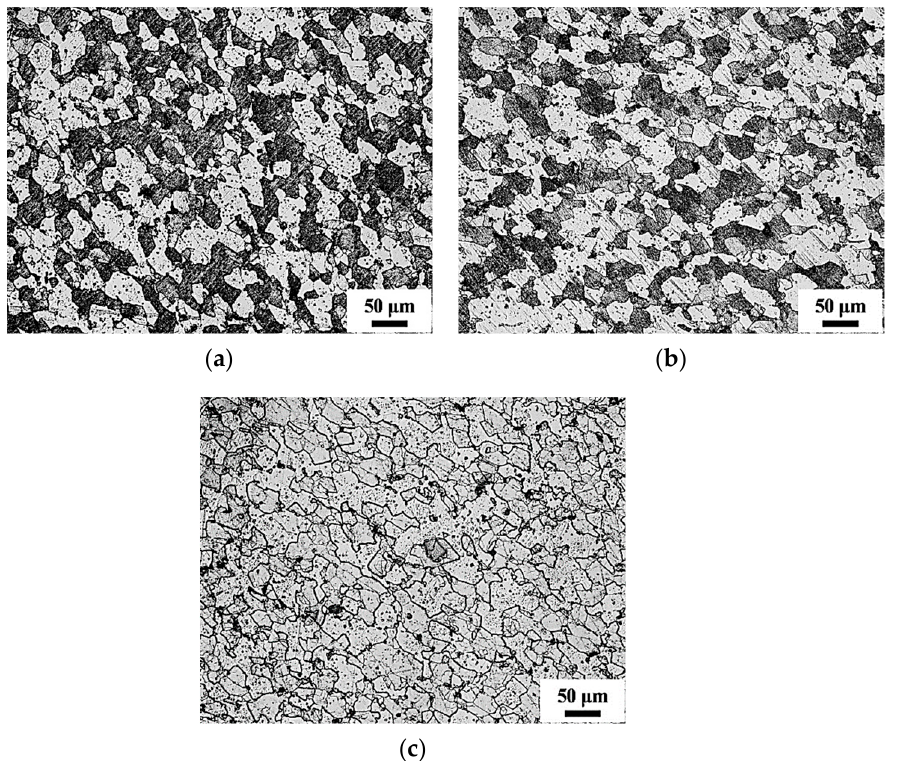
Figure 2. Metallography of alloy at di ff erent aging times: ( a ) solution + aging 18 h; ( b ) solution + aging 24 h; ( c ) solution + aging 36